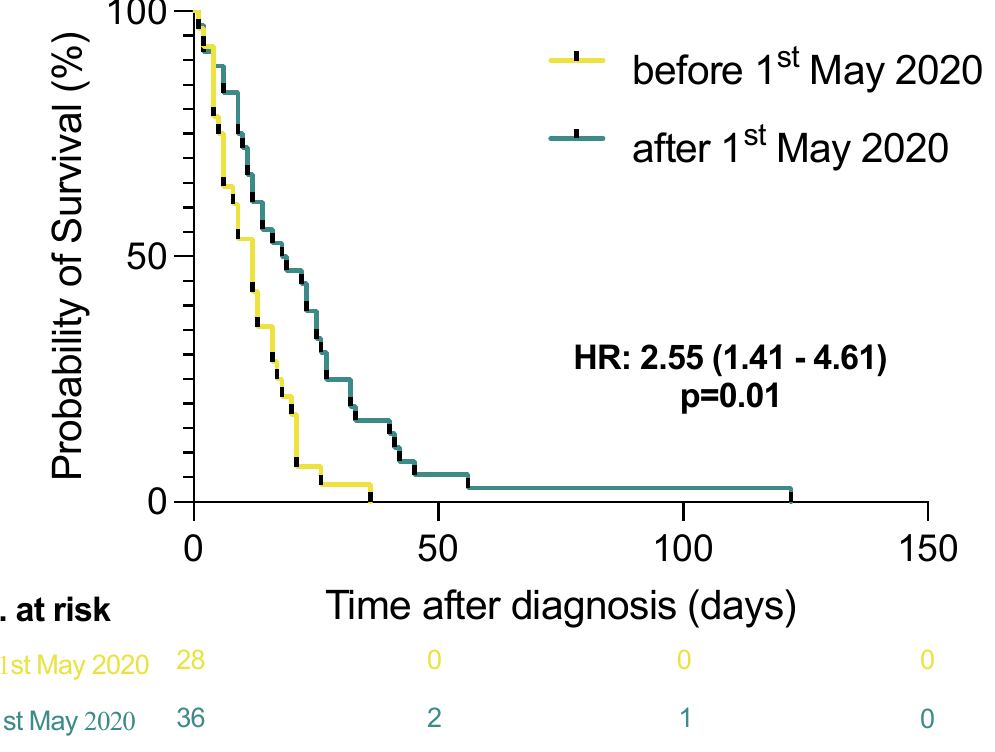
Figure 1. Kaplan–Meier curves display the overall time interval before death of 64 consecutive COVID-19 patients from intensive care units all over the city of Hamburg, autopsied at the Institute of Legal Medicine (University Medical Center Hamburg-Eppendorf, Germany). Survival time was calculated starting from the day of the first positive molecular genetic diagnosis (by RT-qPCR). Patients were grouped according to their admission date before or after adjustments to the local therapy recommendations (in early May 2020). Kaplan–Meier estimates and 95% confidence intervals, as well as hazard ratios (Mantel-Haenszel), are